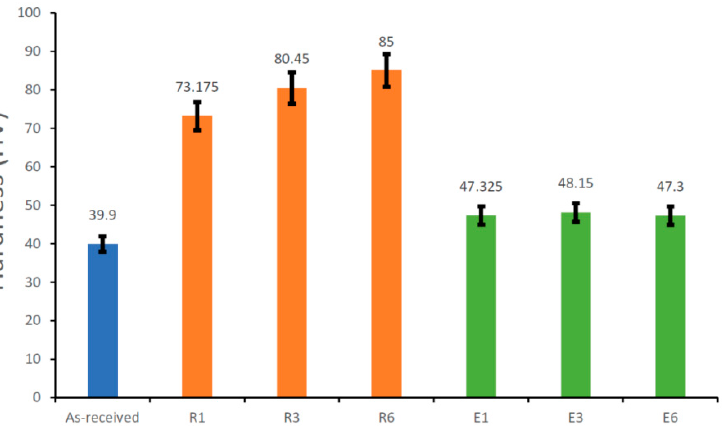
Figure 7. Hardness values changing depending on temperature in 1, 3, 6 pass number (R: Room temperature, E = 250 °C) [63].